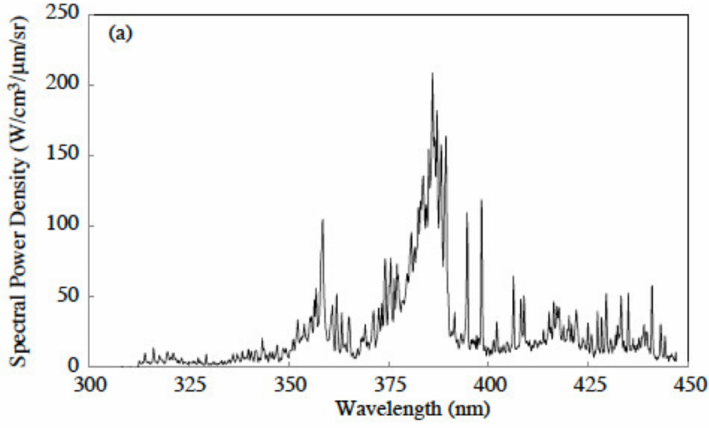
Figure 39. Spectral power density for Mars gas expansion tube study (from [37]).